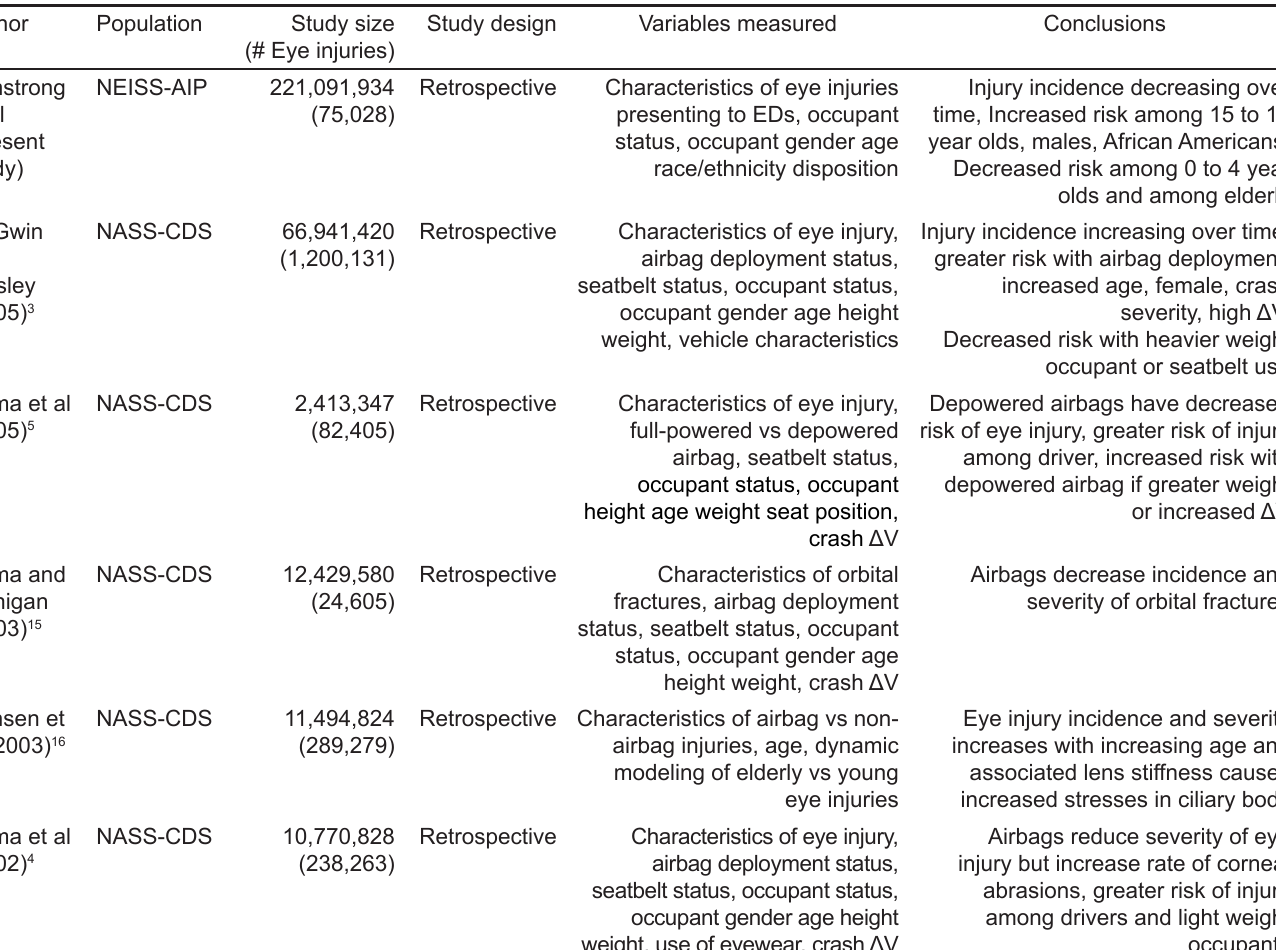
Table 1. Recent nationwide studies of motor vehicle crash-associated eye injuries in the United